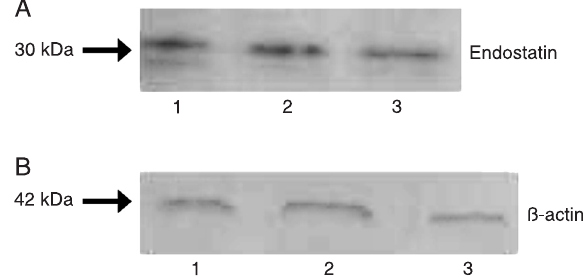
Figure 2. Expression of endostatin in normal and LPS-injured kidneys demonstrated by Western blot analysis. A , Endostatin analysis: normal kidney (lane 1); kidneys at 4 and 12 h after LPS administration (lanes 2 and 3, respectively); B , β-actin analysis in the same kidney